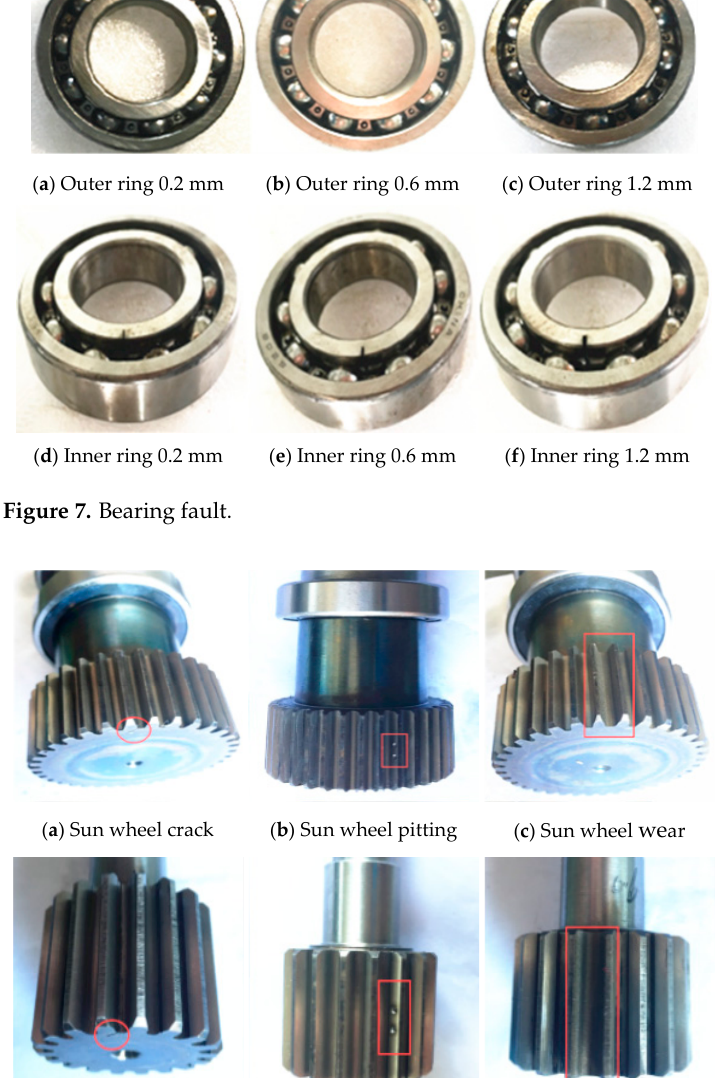
Figure 8. Gear failure. Table 2. Parameters of gear.